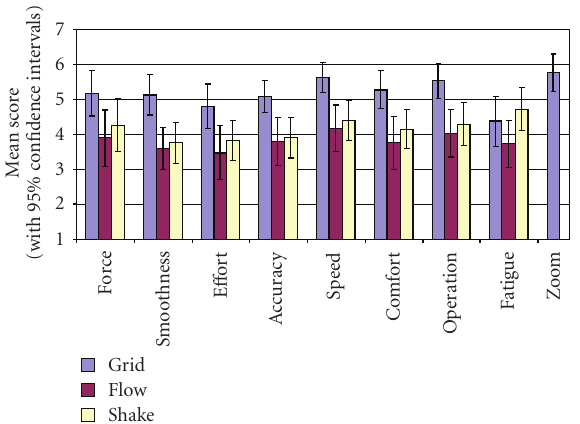
Figure 9: Results of the user interface evaluation questionnaire (studies 1 and 2 combined).